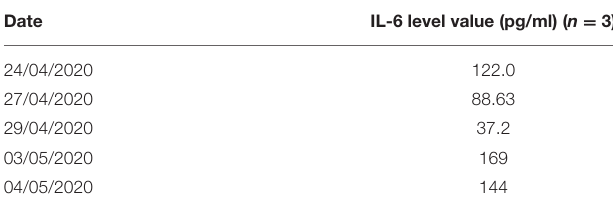
TABLE 2 | Serial interleukin 6 (IL-6) level of the patient.